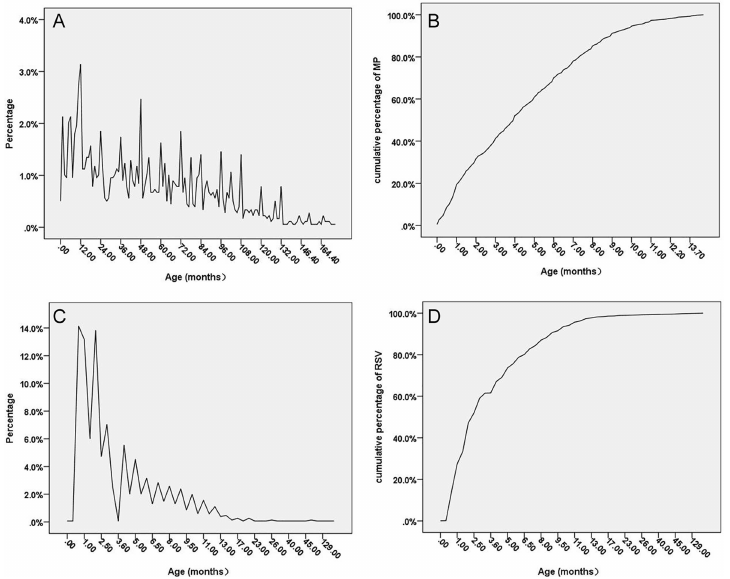
Fig 1. Infection rate for MP/RSV among paediatric pneumonia patients in different age. A: Positive rate for MP by age; B: Cumulative frequencyof paediatricMP pneumoniaby age; C: Positive rate for RSV by age; D: Cumulative frequency of paediatricRSV pneumonia by